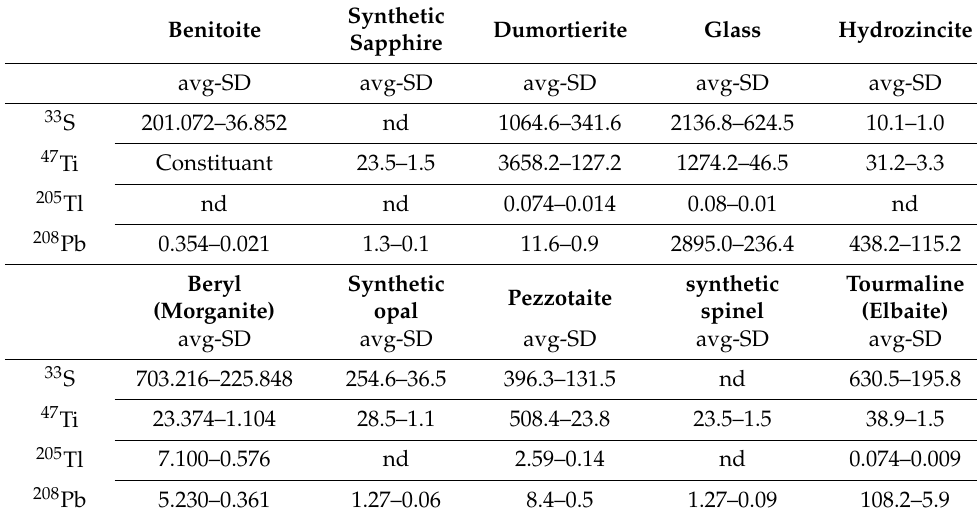
Table 6. Impurities concentrations (ppmw—parts per million weight) of the possible activators of BSL in the ten samples selected obtained by LA-ICP-MS techniques. avg (average), SD (standard deviation), nd (below limit of